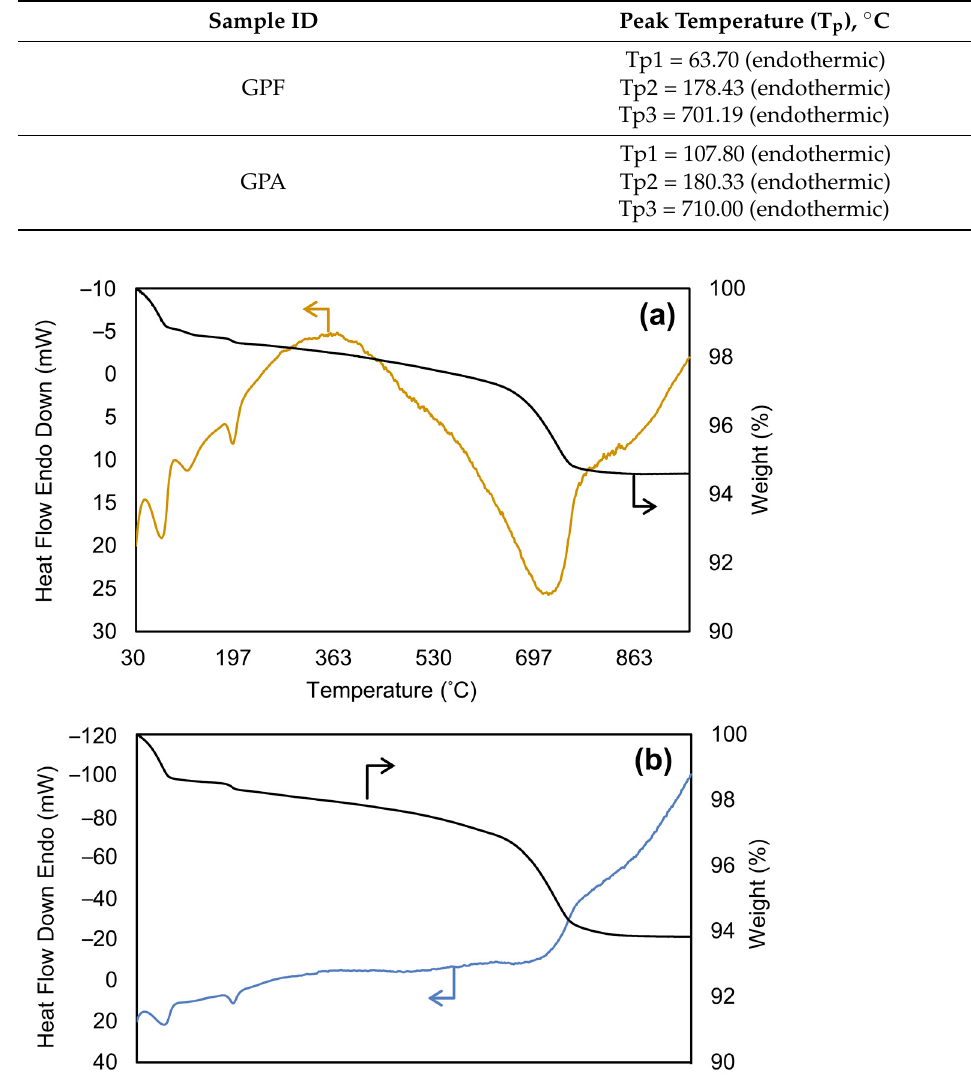
Table 3. DTA peak temperature of the geopolymer composites.